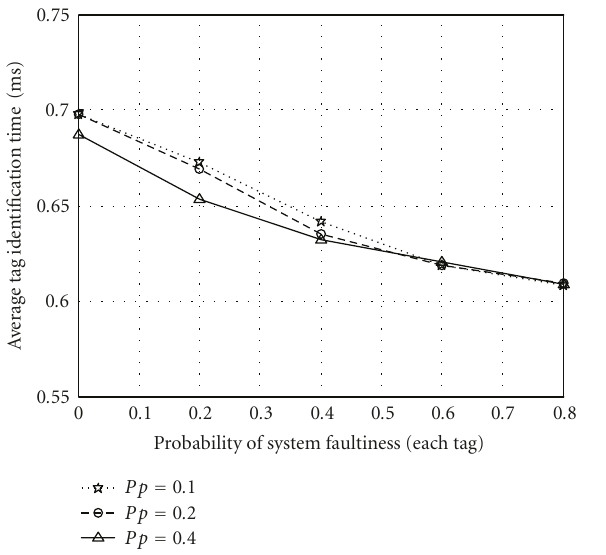
Figure 10: Trend for the average tag identification time for di ff erent combinations of p p and p s .